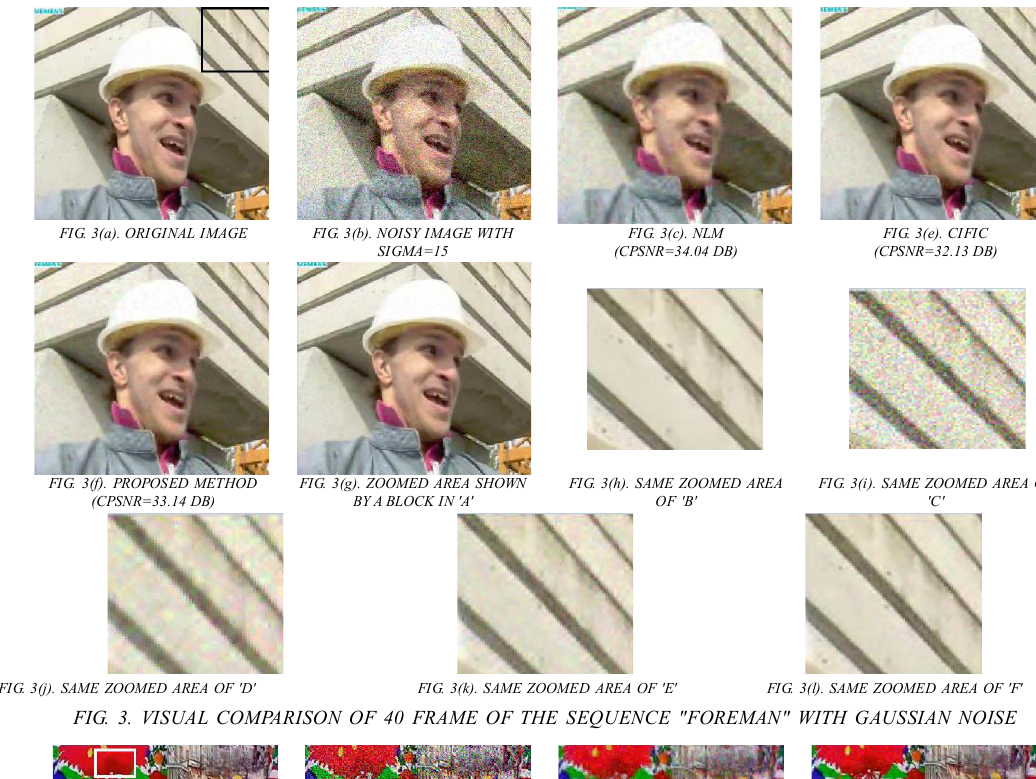
FIG. 3(a). ORIGINAL IMAGE FIG. 3(b). NOISY IMAGE WITH